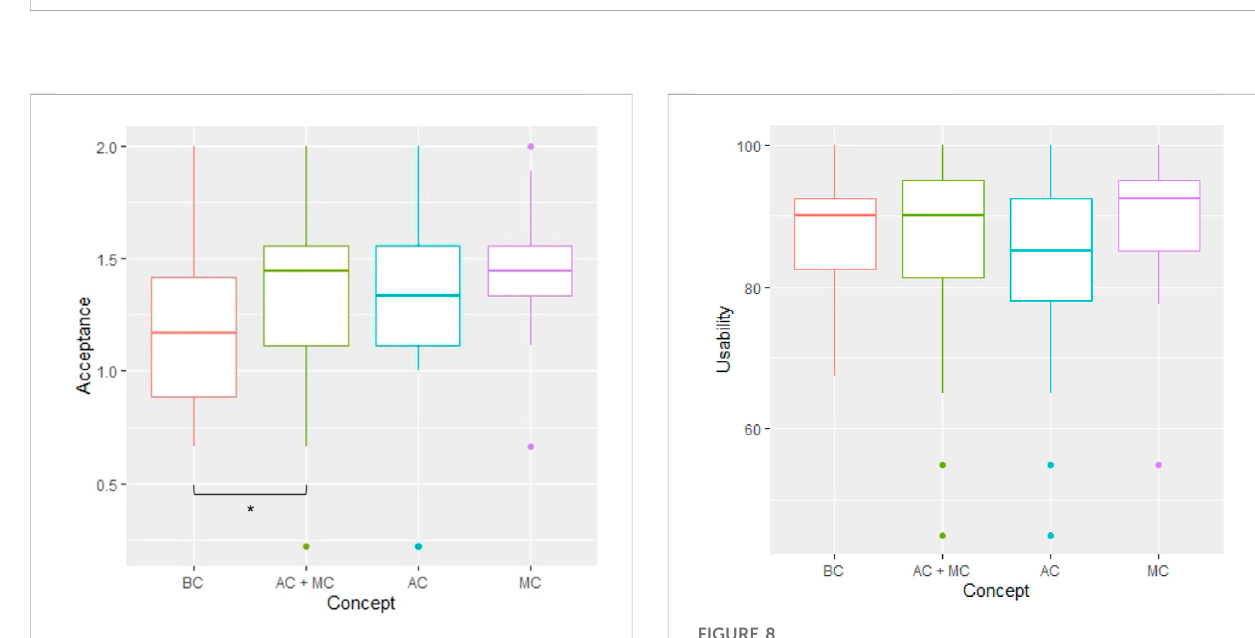
FIGURE 7 Boxplots for the acceptance scores dependent on the HMI concepts. * marks signi fi cant differences.